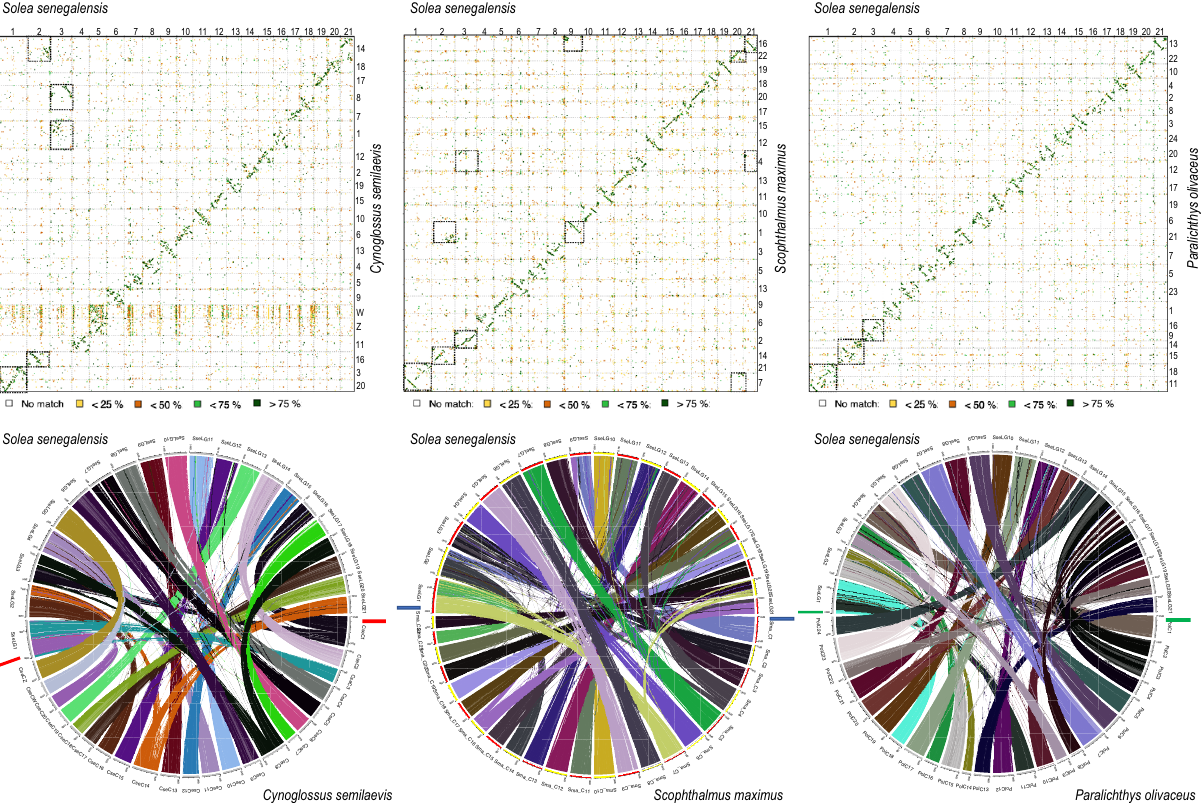
Figure 8. Chromosomal alignment and synteny analysis between flatfish genomes. Top panel, Dot plot comparison of 21 pseudo-chromosomes of S. senegalensis with the genomes of the flatfish C. semilaevis (left), S. maximus (center) and P. olivaceus (right). Chromosome numbers or SseLGs are indicated. The chromosome fusions are boxed. Identity scale is indicated below. Bottom panel, syntenic comparison between flatfish